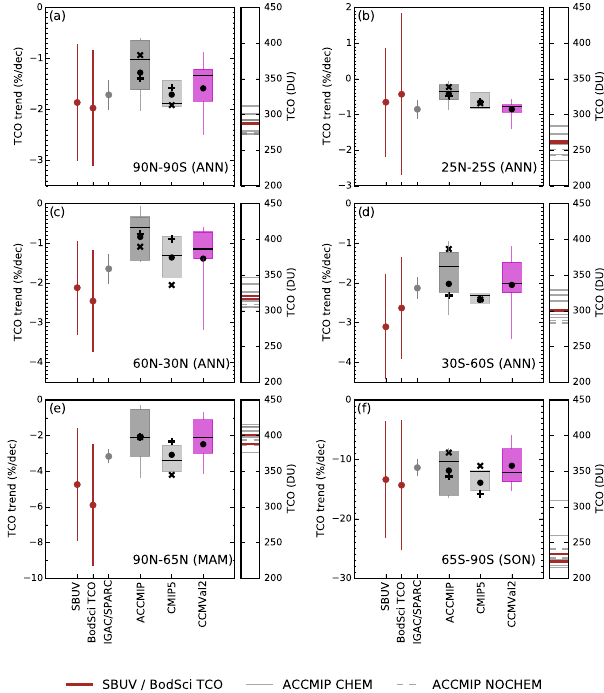
Figure 1. Total column ozone trends from 1980 to 2000 (%dec − 1 ) for the annual mean (ANN) (a) global, (b) in the tropics, (c) in the northern midlatitudes, (d) in the southern midlatitudes, (e) for the boreal spring in the Arctic (MAM), and (f) for austral spring in the Antarctic (SON). The box, whiskers, and line indicate the interquar- tile range, 95% range and median respectively, for the ACCMIP (light grey), CMIP5 (dark grey), and CCMVal2 (magenta) models. Multi-model means are indicated by dots. CHEM (models with in- teractive chemistry) and NOCHEM (models that prescribe ozone) means are indicated by “plus” and “cross” symbols, respectively. Observations and IGAC/SPARC data sets are represented by error bars indicating the 95% confidence intervals (one